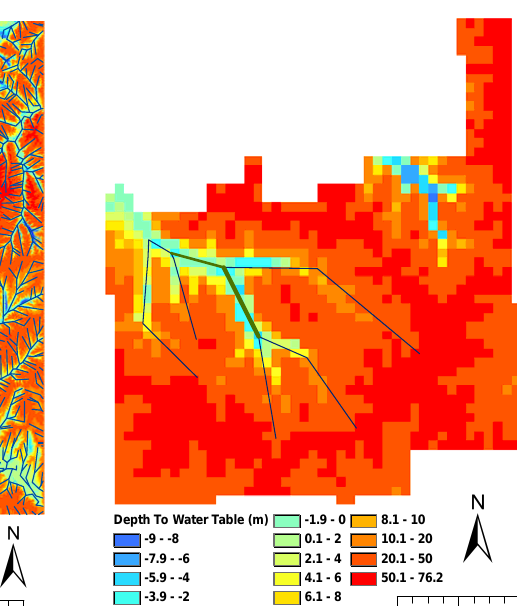
Fig. 7. Groundwater elevation in the study region and at Konza LTER.